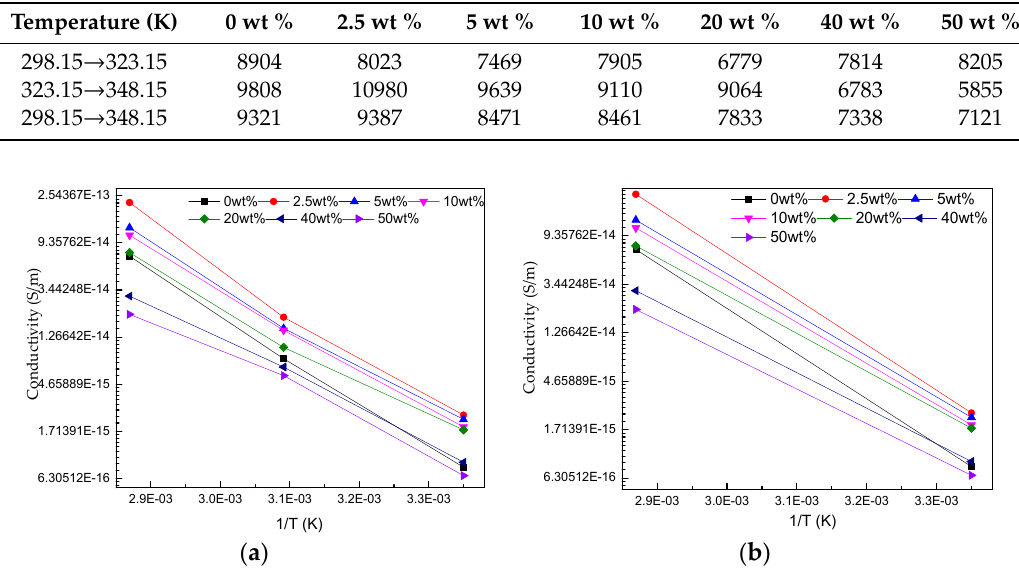
Figure 10. ( a ) The relationship of ln γ and 1/T (temperature change from 298.5 to 323.5 K and 323.5 to 348.5 K); ( b ) The relationship of ln γ and 1/T (temperature change from 298.5 to 348.5 K).